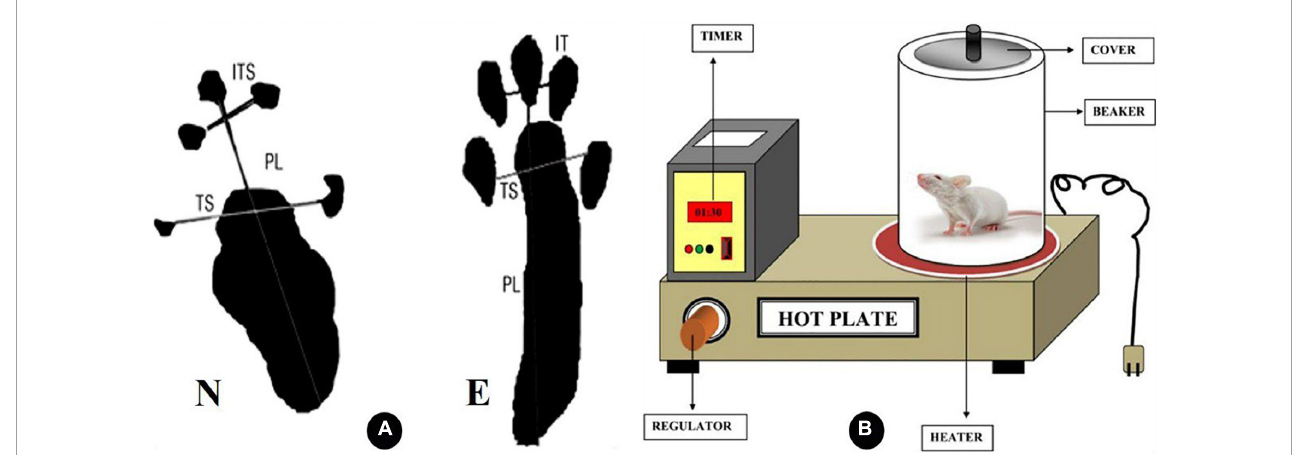
FIGURE1 Diagrammatic illustration of the variables considered in calculating the sciatic function index (SFI) in panel (A) . IT intermediate toes, PL print length, and TS toes spread, as N is the normal leg and E is the experimental leg A (Barbosa et al., 2010). (B) Explanatory diagram of hot plate analgesiometer (Patel et al.,